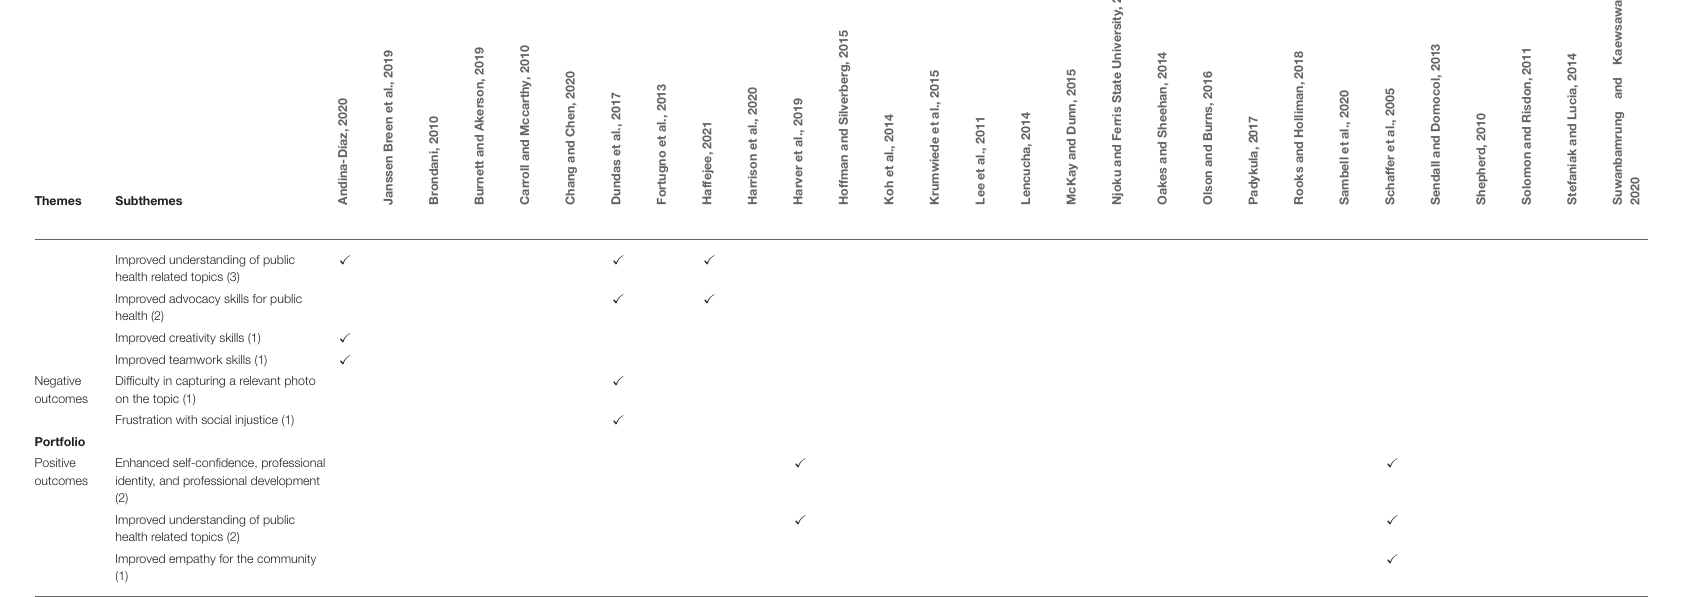
Difficultyincapturingarelevantphoto onthetopic(1) Frustrationwithsocialinjustice(1) X Portfolio Enhancedself-confidence,professional identity,andprofessionaldevelopment Improvedunderstandingofpublic healthrelatedtopics(2) Improvedempathyforthecommunity (1) Number inside the bracket indicates the number of studies with the